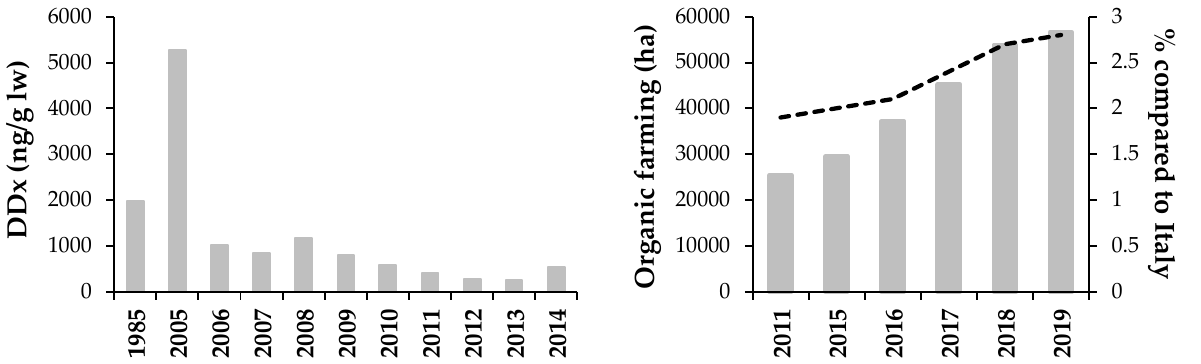
Figure 2. Trend of DDx (concentrations are expressed on lipid weight-lw) from 1985 to 2014 in Lake Como shad Alosa agone (modified from [21,22]) ( left ). Total area (hectares) of organic farming in Lombardy, and the percentage compared to Italy (data from [25–29]) ( right ).